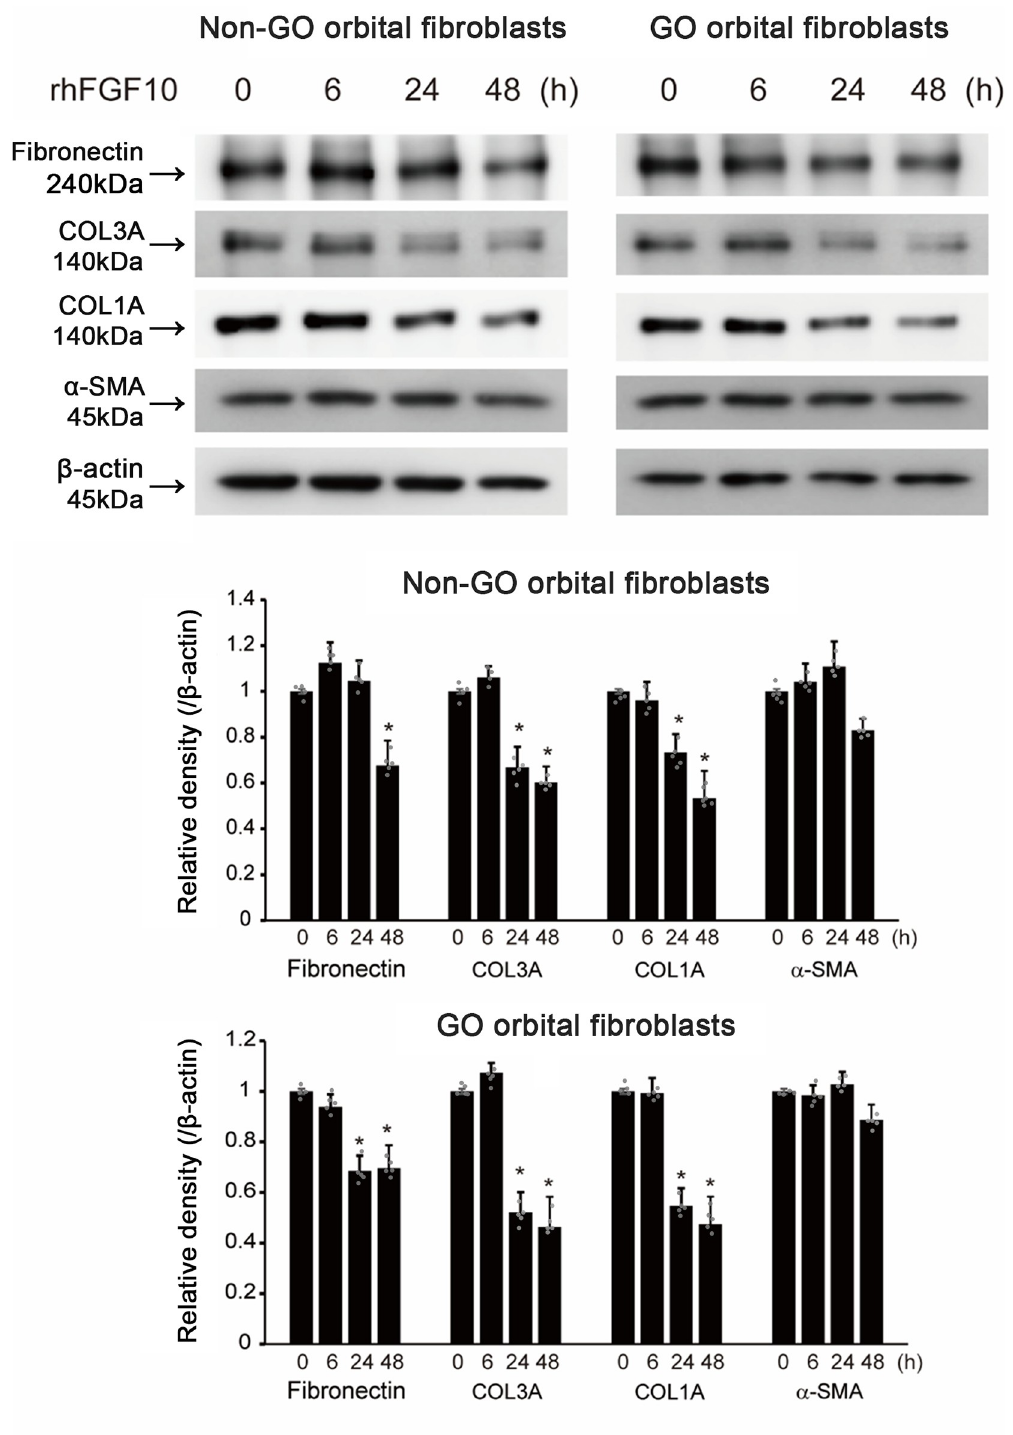
Fig 3. Inhibitory effect of FGF10 on Graves 0 orbitopathy (GO) and non-GO orbital fibroblasts. After treatment with 100 ng/mL of rhFGF10 for 0, 6, 24, and 48 h, fibronectin, collagen IIIa (COL3A) and collagen I α (COL1A) protein expression was significantly decreased at 24 h or 48 h. Bar graphs show the relative density of each protein normalized to the level of β -actin and are represented as means ± standard deviation. Experiments were performed using at least three cells from different strains. � p <